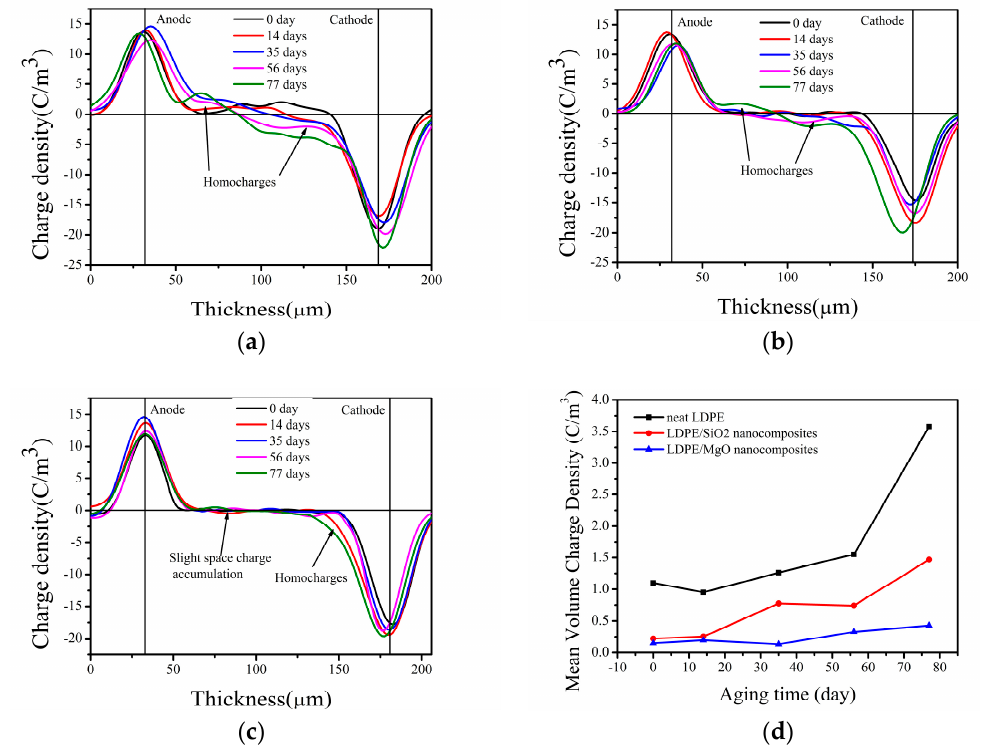
Figure 4. Space charge and mean volume charge density of neat LDPE and 1 wt %-nanocomposites ( a ) space charge curves of neat LDPE; ( b ) space charge curves of LDPE/SiO 2 nanocomposites; ( c ) space charge curves of LDPE/MgO nanocomposites; ( d ) mean volume charge density.